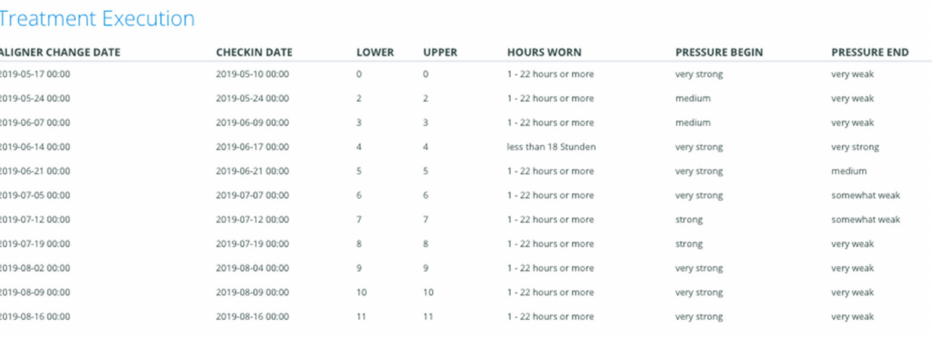
Figure 2. A representation of the patient treatment execution data collected through the app- based questionnaire.